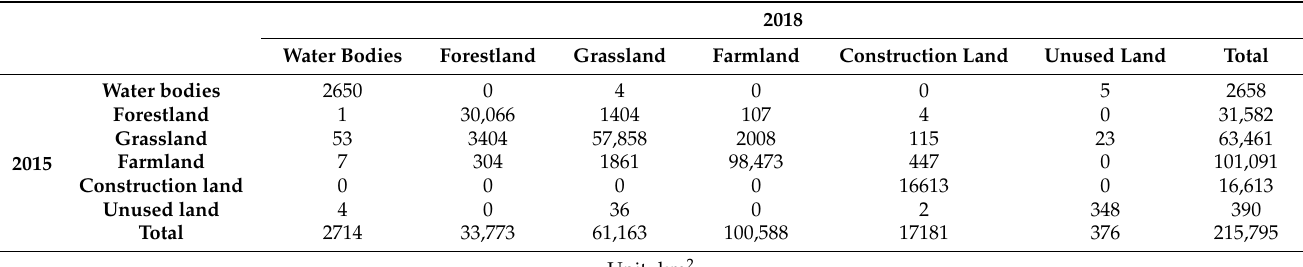
Table 4. Land use transfer matrix from 2015 to